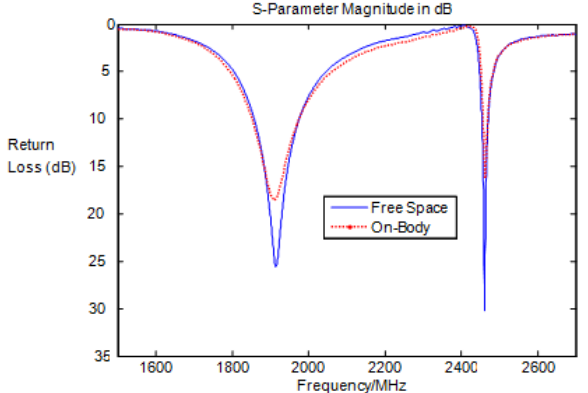
Figure 3. Simulated free space and on-body (1 mm away from human body) return loss responses of the dual band PIFA.